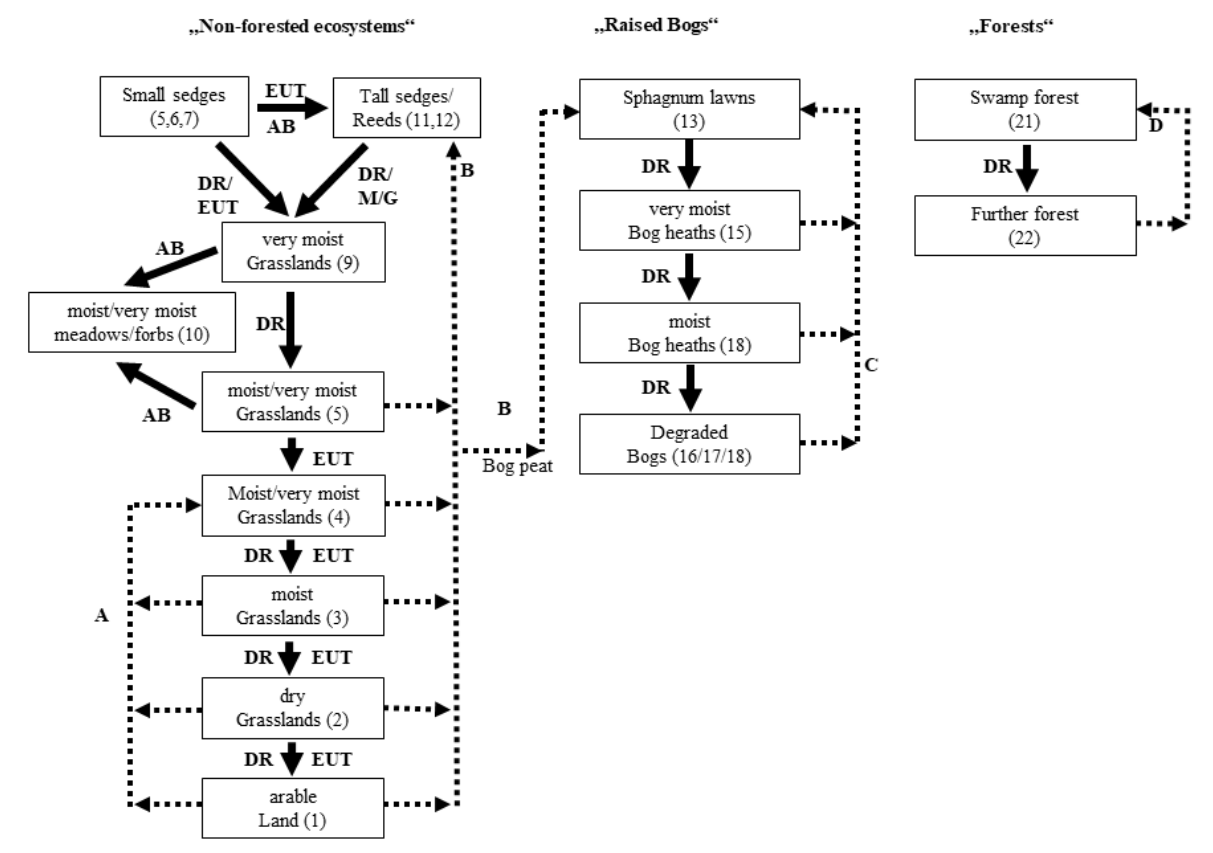
Figure 1. Successional pathways for rewetting measures of peatlands (A–D) in Schleswig-Holstein. Different vegetation types (1–22; see Appendix) and their corresponding Greenhouse Gas Emissions Site Types (GEST) are